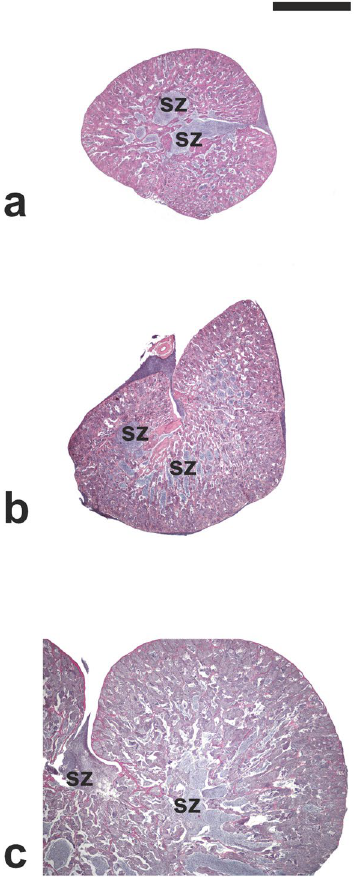
Figure 2. Micrographs of testis sections from juvenile meagre. ( a ) Testis section of an untreated fish (CONTROL 0 group); ( b ) Testis section of a fish treated with saline solution for 6 weeks (CONTROL 6 group); ( c ) Testis section of a fish treated with rFsh for 6 weeks (TREATED group). H-E staining. Magnification bar = 1 mm. sz =